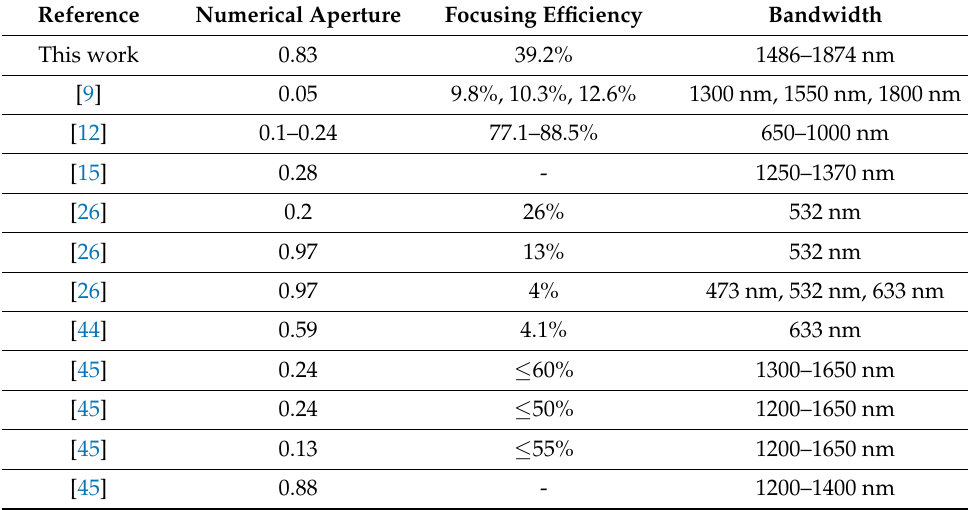
Table 1. Comparison of results with previously reported metalenses.